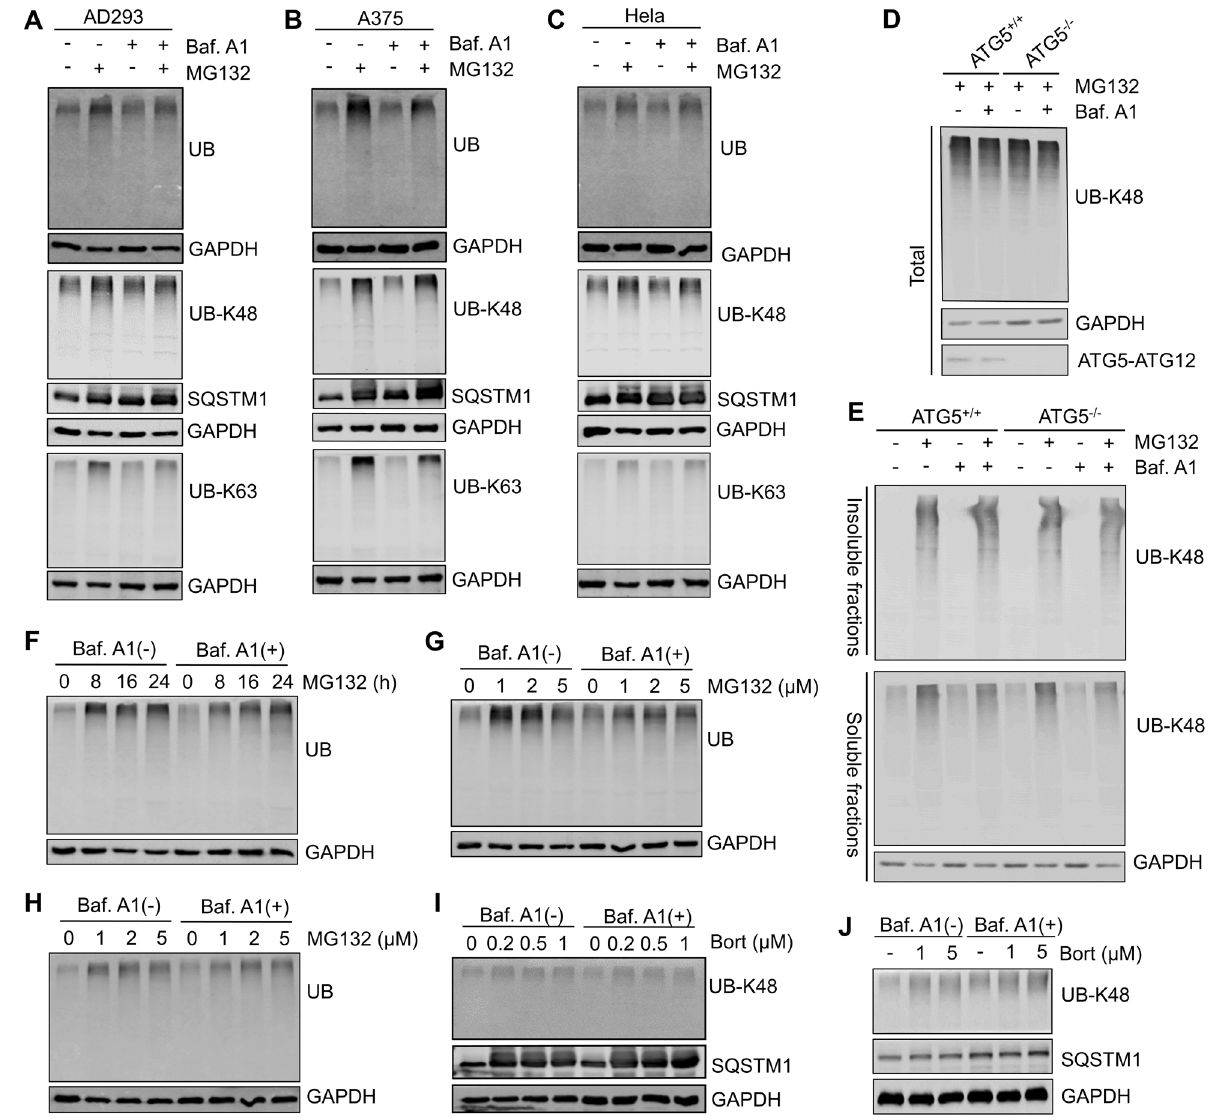
subjected to western blot analysis with indicated antibodies. D , E Wild-type (ATG5 + / + ) or ATG5 knockout (ATG5 − / − ) AD293 cells were treated with DMSO (control), or MG132 (2 μ M), and Ba fi lomycin A1 (25 nM), alone or in combination for 14 h. The whole-cell lysates (Total), NP-40- soluble and -insoluble fractions were subjected to western blot analysis with indicated antibodies. F AD293 cells were treated with MG132 (2 μ M) for the indicated time with or without Ba fi lomycin A1 (25 nM). The whole-cell lysates were subjected to western blot analysis with indicated antibodies. G , H AD293 cells ( G ) and A375 cells ( H ) were treated with MG132 at indicated concentrations with or without Ba fi lomycin A1 for 14 h (25 nM), and then the whole-cell lysates were subjected to western blot analysis with indicated antibodies. I , J A375 cells ( I ) and HeLa cells ( J ) were treated with Bortezomib at indicated concentrations with or without 25 nM Ba fi lomycin A1 for 14 h, and then the whole- cell lysates were subjected to western blot analysis with indicated